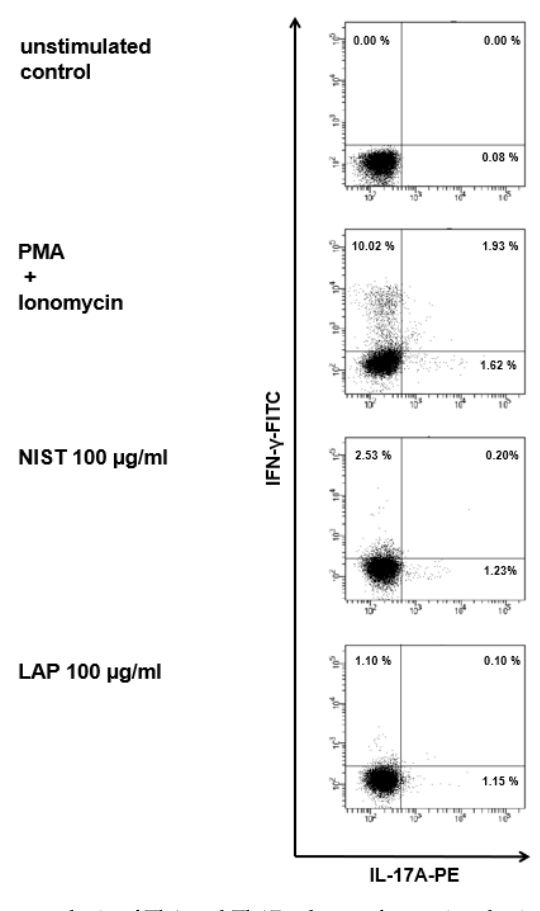
Figure 6. Flow cytometry analysis of Th1 and Th17 subsets after co-incubation of purified monocytes exposed to TMCPM with T lymphocytes. Dot plots (IFN-γ-FITC vs. IL-17A-PE) show CD4+ T cells positive for IFN-γ and IL-17A in unstimulated control, cells stimulated with PMA (50 ng/mL) + ionomycin (100 ng/mL) (positive control) and stimulated with NIST (100 μg/mL) or LAP (100 μg/mL). Shown are data from one representative experiment out of six performed. The expression of intracellular IFN-γ and IL-17A was analyzed by flow cytometry after the cells were stained with the cocktail of fluorescently conjugated monoclonal antibodies, specific for IFN-γ (Th1) and IL-17A (Th17).